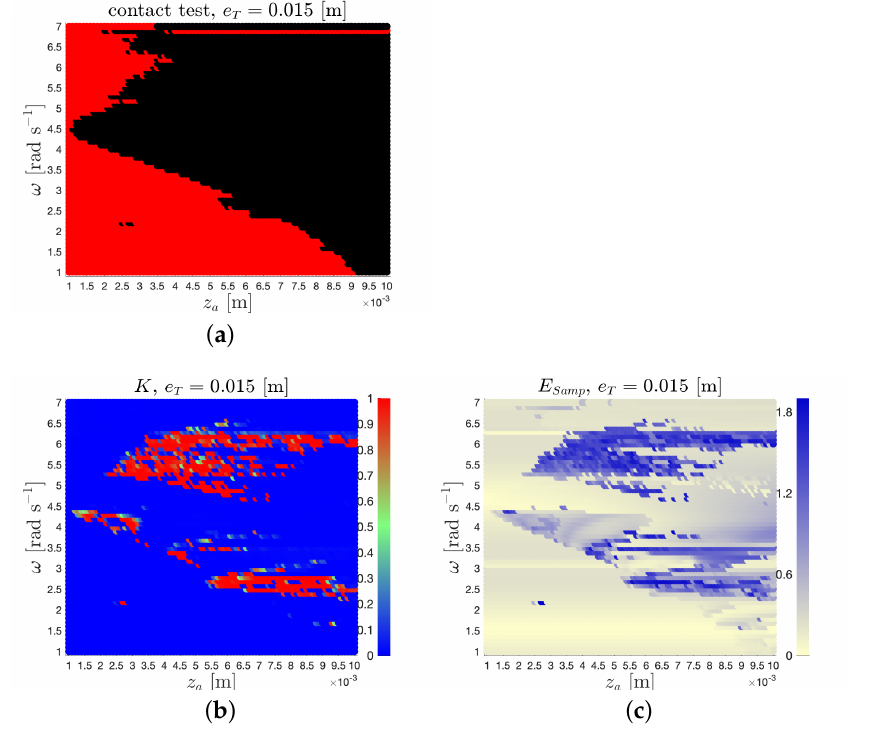
Figure 14. Outputs of the contact test ( a ), the 0–1 test for chaos K ( b ), and sample entropy E Samp ( c ) for eccentricity e T of 0.015 m with respect to the excitation frequency ω and amplitude z a